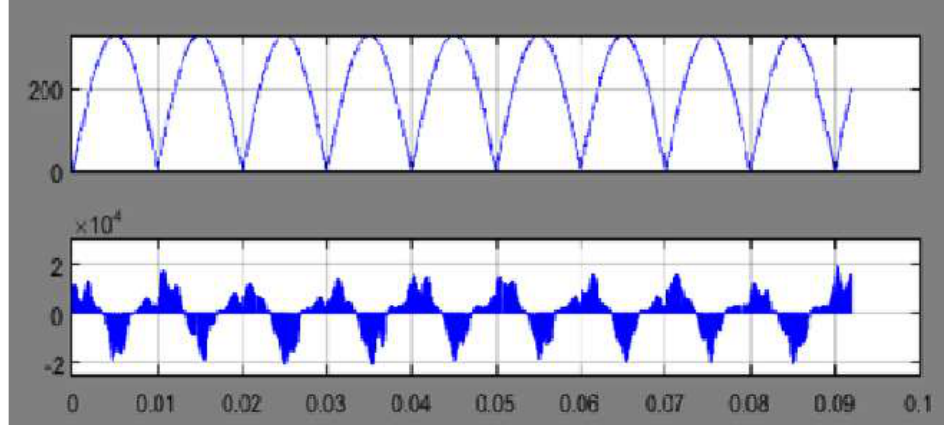
Figure 15. Sine and triangle wave reference.